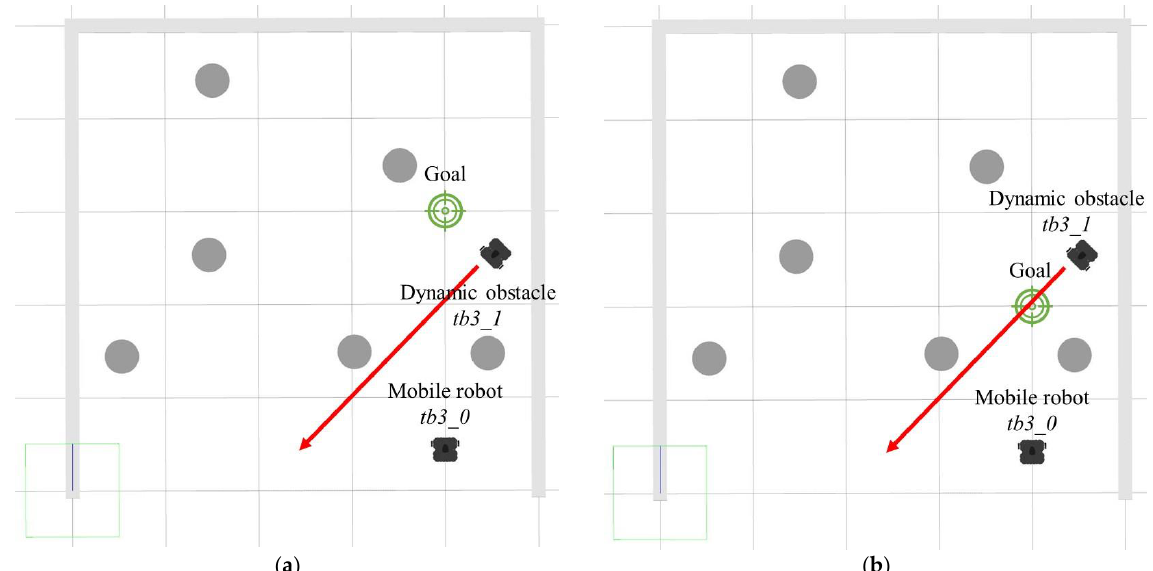
Figure 15. ( a ) Gazebo simulation for dynamic environment scenario 3 with goal point of (4.0,3.0) ( b ) Gazebo simulation for dynamic environment scenario 3 with goal point of (4.0,2.0) for 𝑡𝑏3_0 .